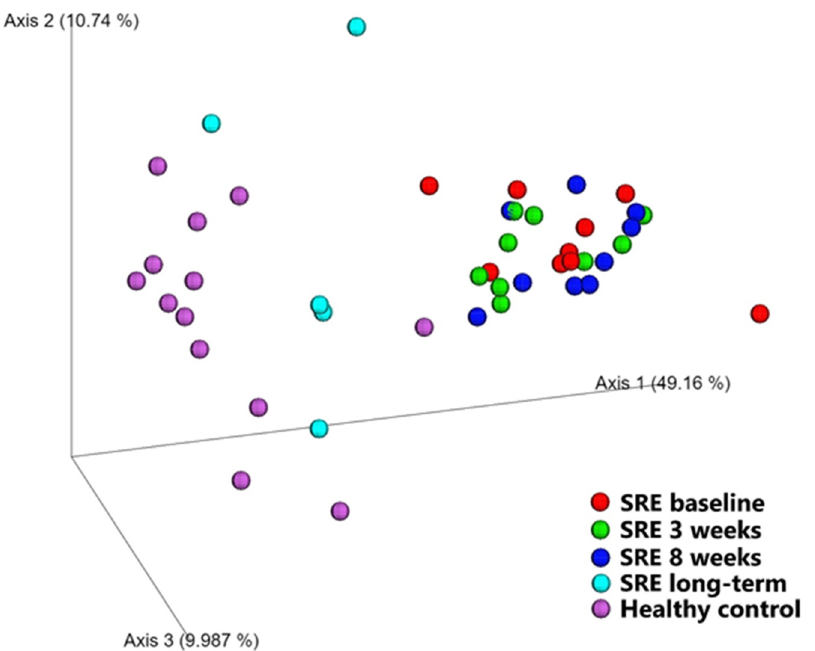
Figure 1. PCoA plot based on weighted UniFrac distances. Samples from healthy control dogs (pink dots) are seen towards the left of the plot, while samples from dogs with SRE at baseline (red dots) can be seen towards the right. While no significant changes from baseline were observed after 3 weeks (green dots, p = 0.2) or 8 weeks (blue dots, p = 0.2), samples collected 1 year after the initiation of treatment (cyan dots) were significantly different from baseline ( p < 0.001) and no longer significantly different from healthy control dogs ( p = 0.1).